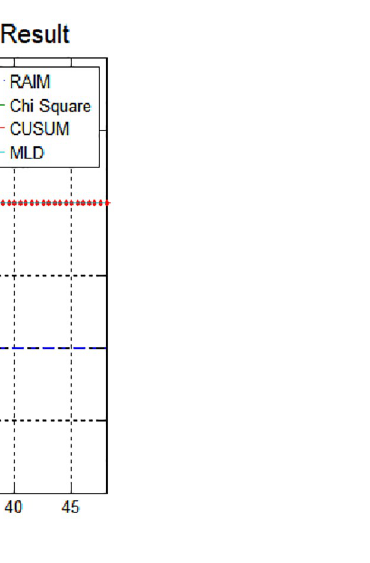
Fig 10. Spoofing detection result.